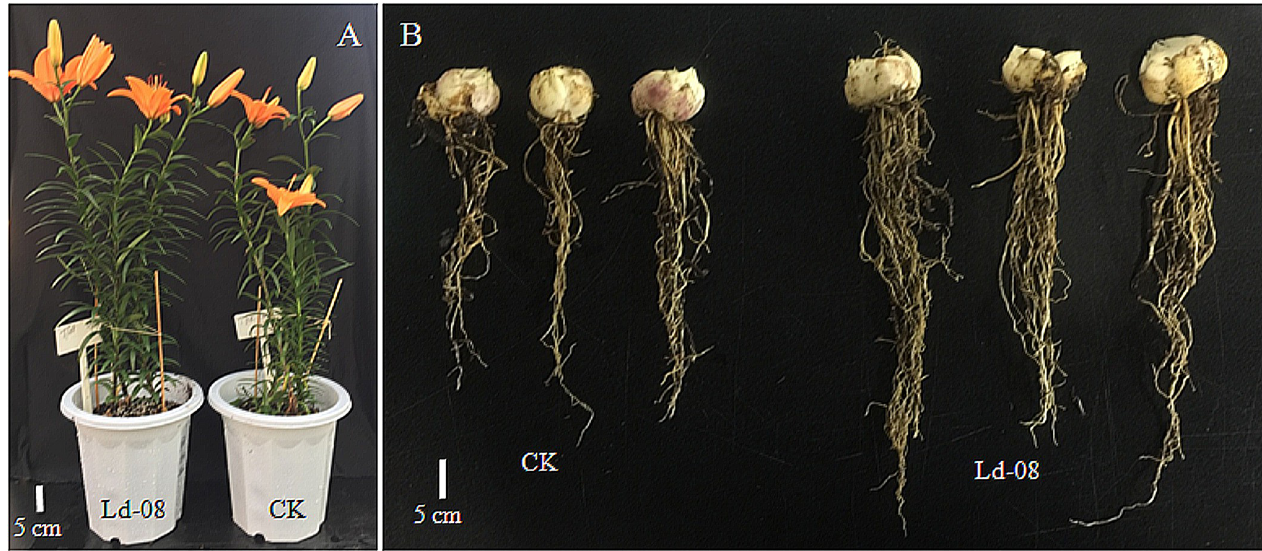
Fig 5. Plant growth promotion in Lilium variety “Tresor” upon inoculation of bulbs with Ld-08. (A) Relative plant height of Ld-08-inoculated and control plants (CK). (B) Relative root lengths of inoculated and control plants.